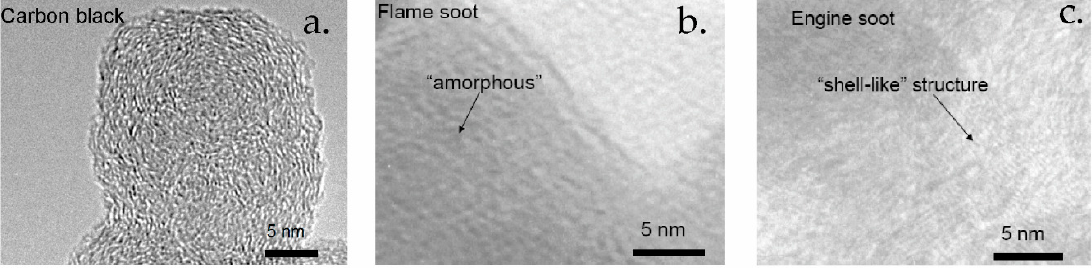
Figure 2. HTEM soot images. ( a ) Printex-U Carbon Black (CB); ( b ) Flame soot FS100; ( c ) Engine soot (DS).